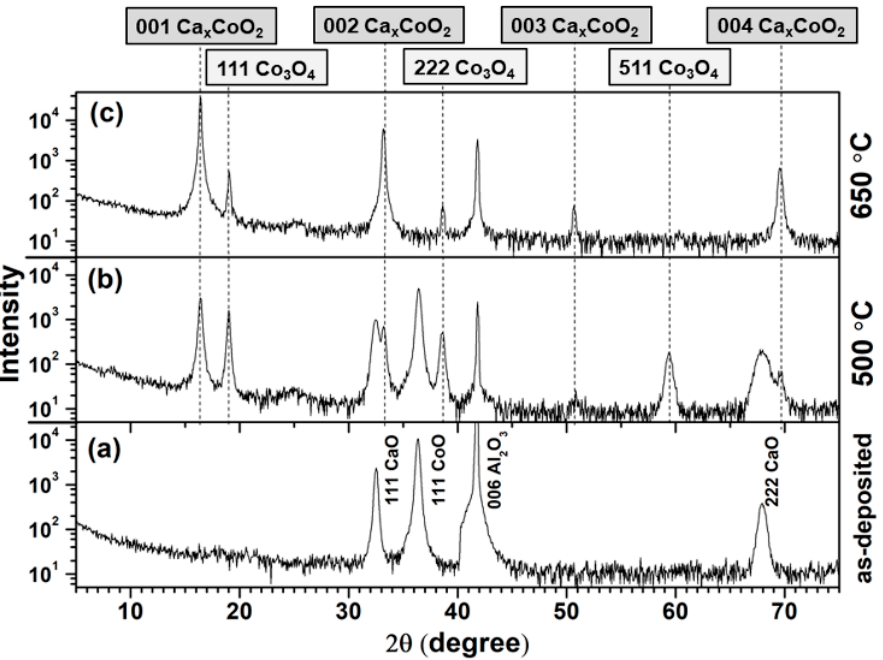
Figure 6. θ –2 θ XRD patterns of the Ca:Co = 0.35 thin film as a function of annealing temperature. ( a ) As-deposited film, ( b ) annealed at 500 ◦ C, ( c ) annealed at 650 ◦ C.